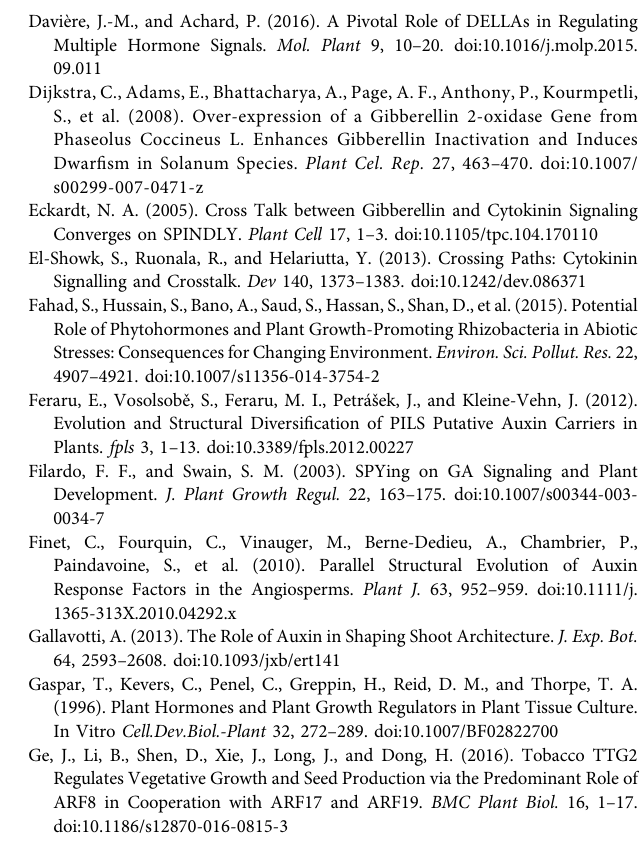
phosphotransfer 1 ( AHP1 ), Arabidopsis histidine phosphotransfer 5 ( AHP5 ), Arabidopsis response regulator ( ARR2 ), KORRIGAN ( KOR ), and Arabidopsis Histidine Kinase ( AHK3 ) (C) . Expression levels in leaves, stems, and nodes of weedy and cultivar types. Total RNA was prepared from the 12-week-old plants for the indicated samples. Control plants were weedy type (WT). Error bars indicate SD of triplicate measurements. GmAct6 was used as internal control, and relative expression levels are shown as fold values. Supplementary Figure 2 | Expression pro fi les of the DEGs using Volcano and Minus-versus-Add (MA) plots. (A) Volcano plot of the upregulated and downregulated DEGs of the stems between the weedy and cultivar growth types. The down-regulated DEGs are on the left side, and up-regulated DEGs are on the right. Red indicates DEGs with p -value < .01 and LFC ≥ 1; green indicates p -value between .01 and .05, and LFC ≥ 1; yellow indicates p -value < .01 and LFC ≥ 1; and black indicates p -value < .05 and LFC ≤ 1. For each plot, the x-axis represents the log 2 fold change (LFC), and y-axis represents − log 10 ( p -values). (B) MA plot of the DEGs of the stem between the weedy and cultivar growth types. The x-axis represents the mean of the normalized counts of the genes, and the y-axis indicates the log 2 fold change. Red points represent up- regulated DEGs, blue points represent down-regulated DEGs, and black points represent non-DEGs. Supplementary Figure 3 | Relevant part of GA biosynthesis pathway and crosstalk. Solid boxes indicate the bioactive form of the GA, and the names with arrow headed are the catalyzing enzymes. The dashed box and line represent the inactive form of the GA. The upward headed arrow represents up regulation of the phytohormone response genes. After the subsequent process and interaction with other phytohormone response genes results into bioactive and inactivate GAs. ( GA2ox - Gibberellin 2 oxidase, GA3ox – Gibberellin 3 oxidase, ARF – Auxin response factor, CKX – Cytokinin dehydrogenase, PILS – PIN Like proteins, KAO – ent-kaurenoic acid oxidase). Interaction of these genes in GA pathway results in morphology variation in soybean plants. Adapted and modi fi ed from (Ross et al., 2001; Yamaguchi, 2008; Nomura et al.,